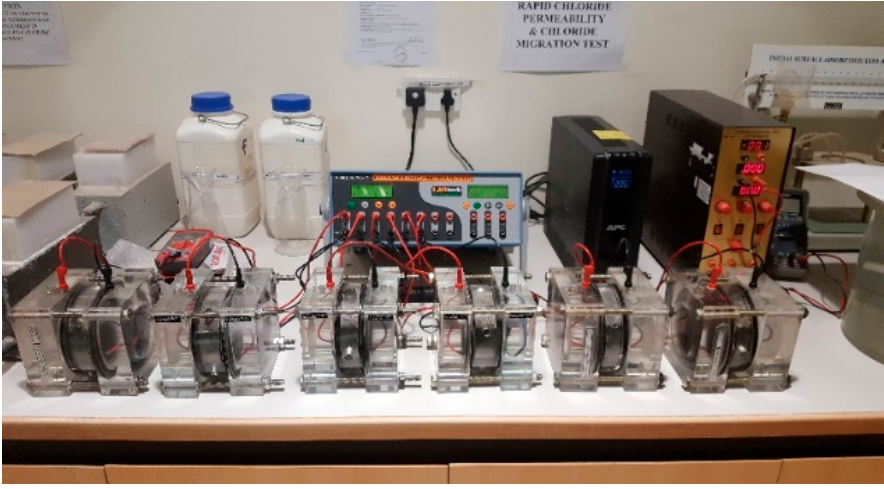
Figure 3. Rapid Chloride Ion Penetration test set up.